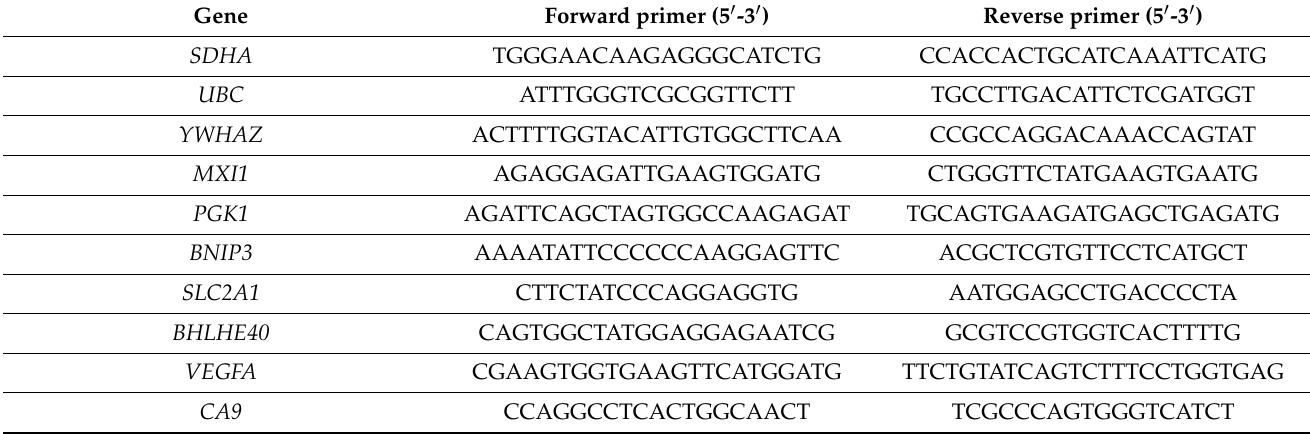
Table 1. Primer Sequences for